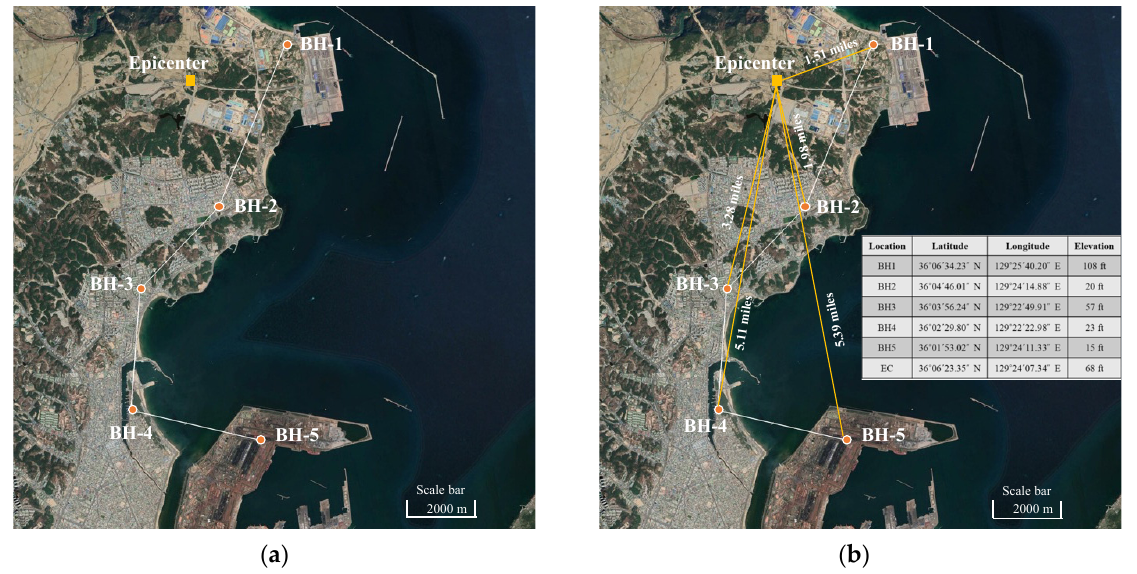
Figure 1. Geographical locations of epicenter of Pohang earthquake considered in this study. ( a ) Locations of epicenter and borehole; ( b ) geographical details of locations.